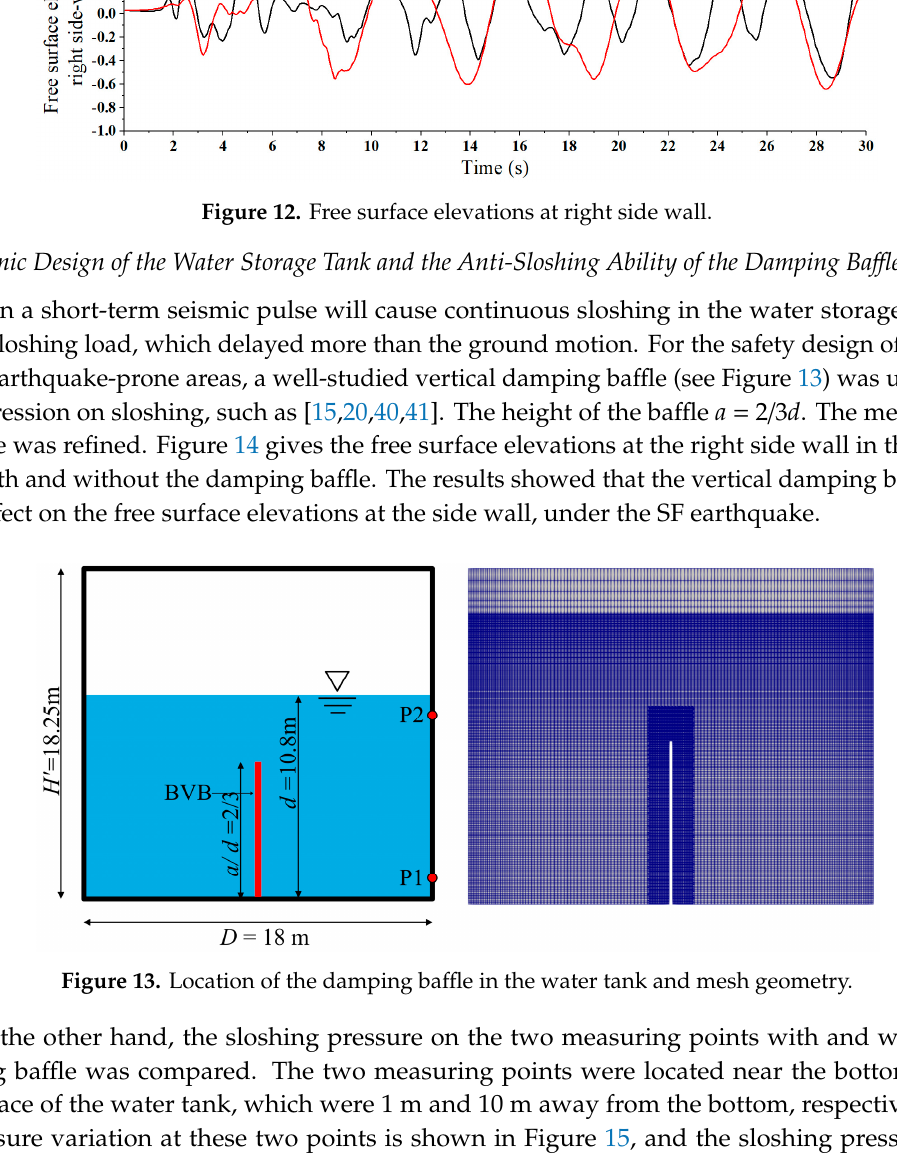
Figure 12. Free surface elevations at right side wall.